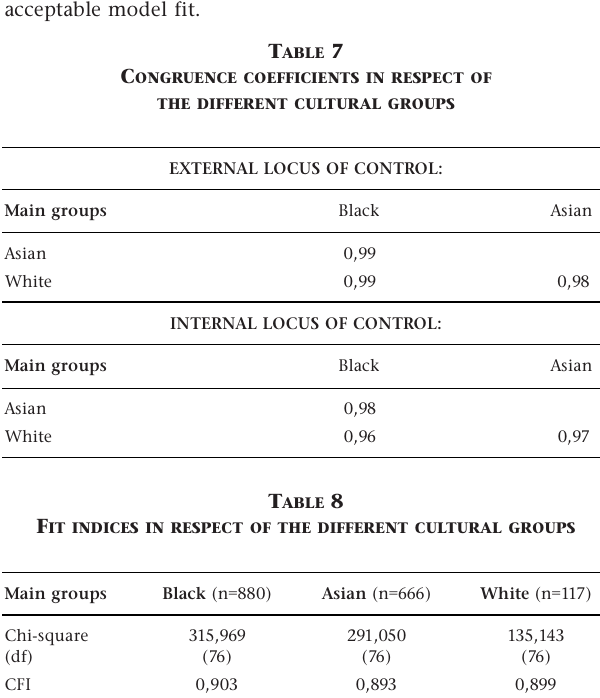
Figure 5: Standardised estimated parameters of the PIB/ SPEEX Motivation Index for the Asian group